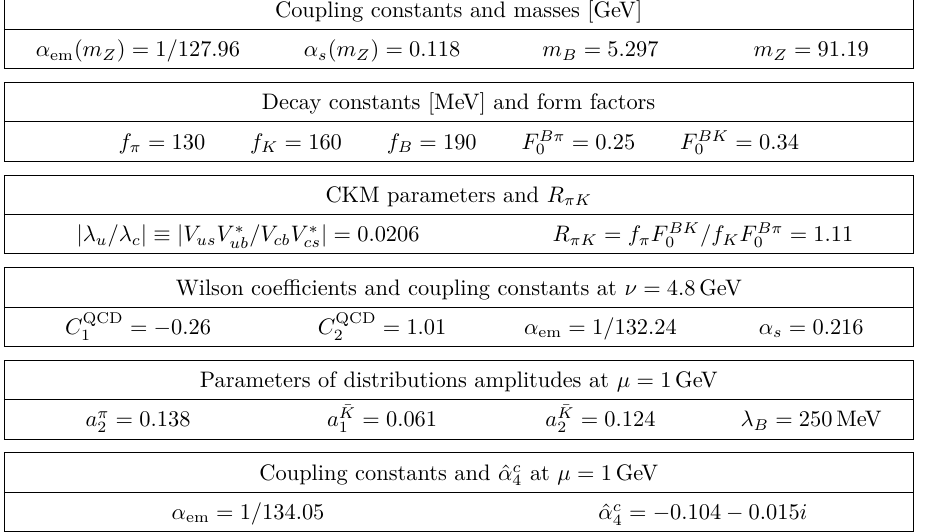
Table 1 . Inputs for the estimate of the QED effects. The Gegenbauer coefficients are taken from [34] and evolved to 1 GeV with LL accuracy. The pure QCD Wilson coefficients are evaluted at the NNLL